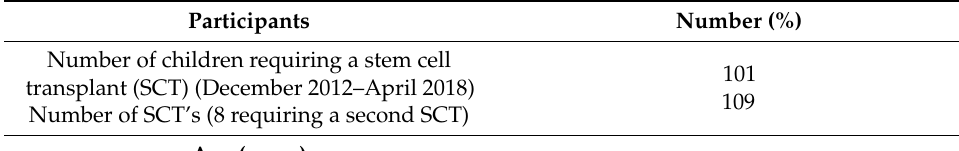
Table 1. Characteristics of participants and stem cell